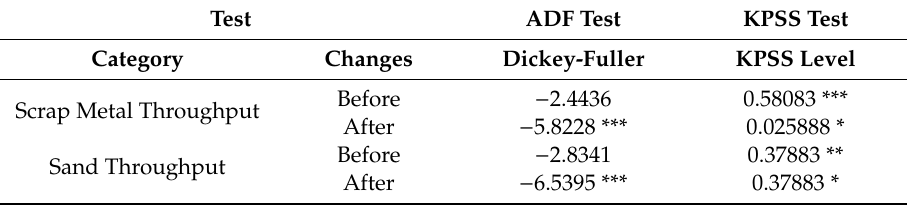
Table 2. The stationarity process of scrap metal and sand throughput time series